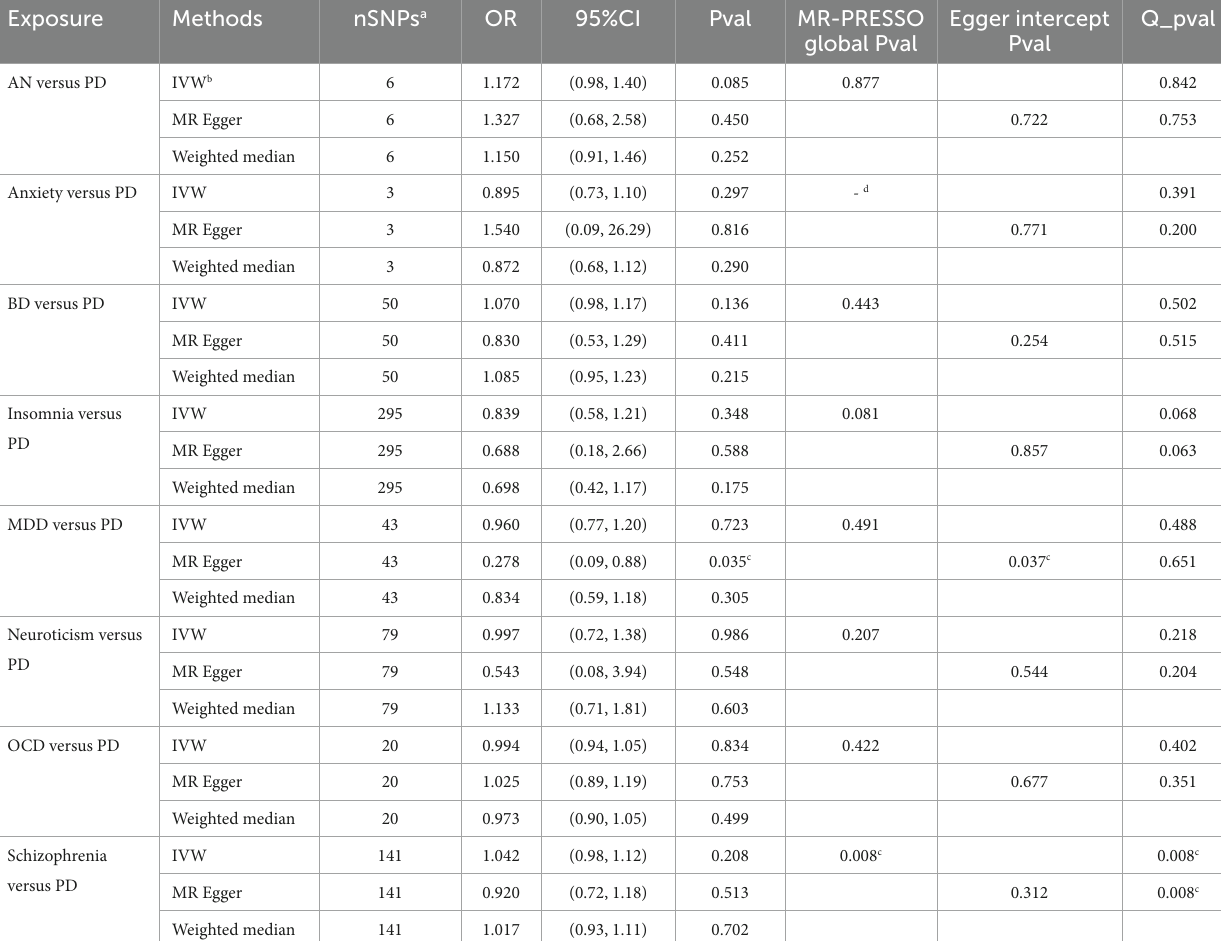
TABLE 2 Causal relations of psychiatric disorders with PD (IPDGC). Exposure